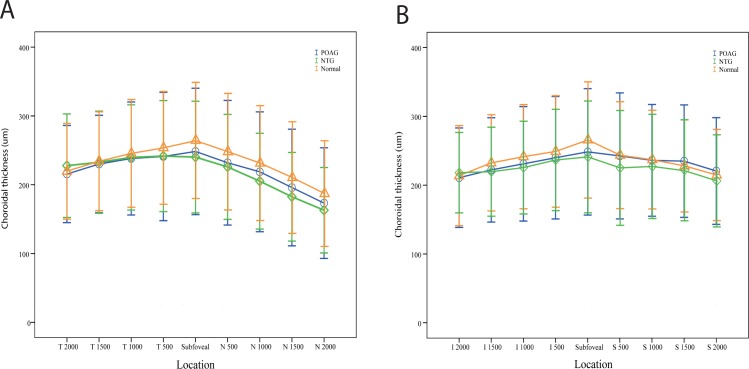
Graphs showing the comparison of choroidal thickness in the macular region using the raw data.(A) choroidal thickness in a horizon scan (B) choroidal thickness in a vertical scan.